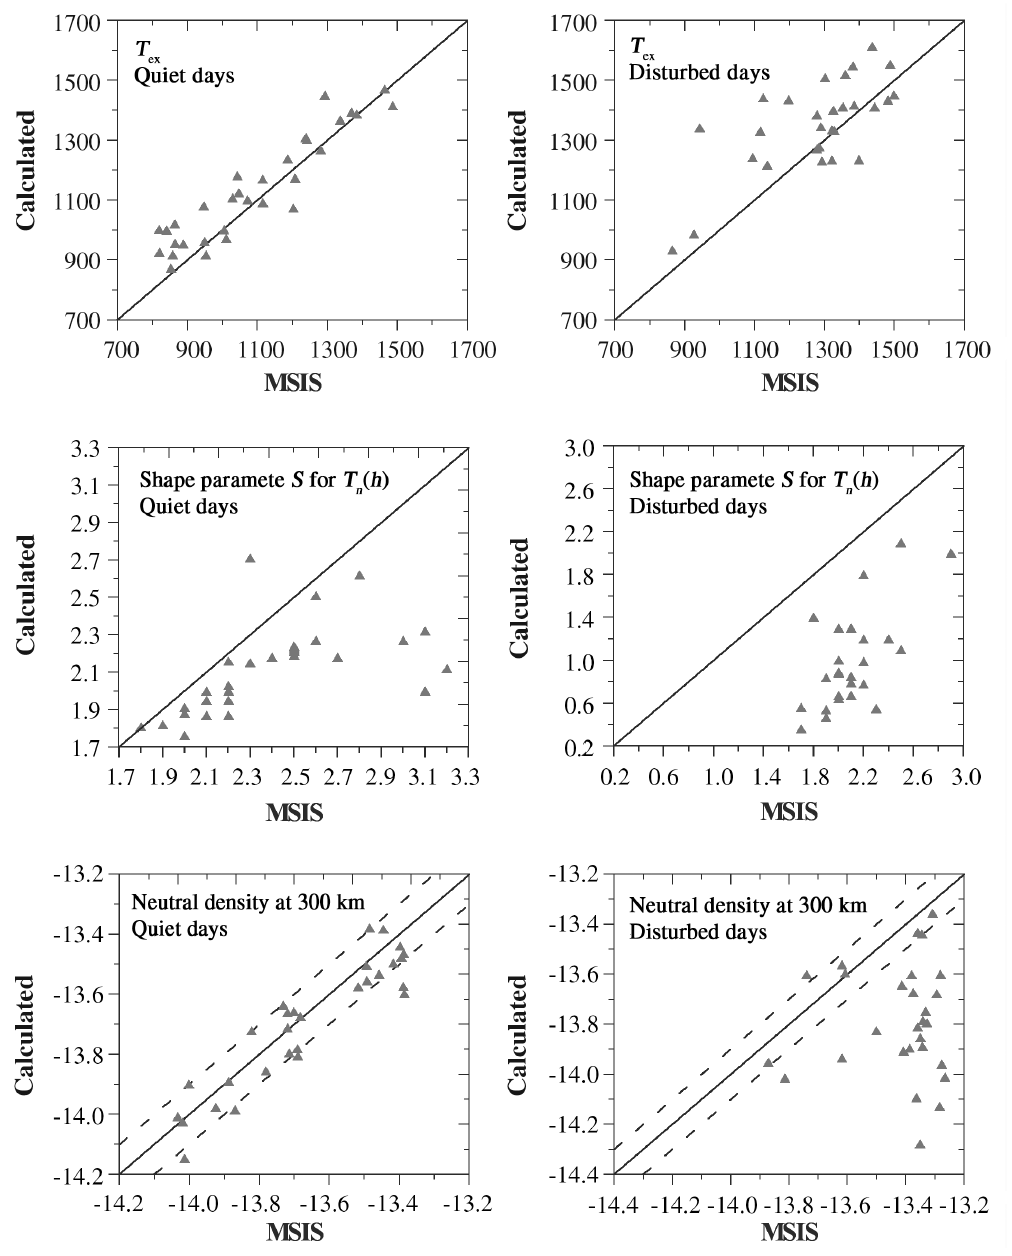
Fig. 4.5. A comparison of calculated versus MSIS-86 exospheric temperature T ex , shape parameter S , and total neutral density ρ at 300 km for quiet (left-hand panels) and disturbed (right-hand panels) days. T ex is in K , S is in 10 -2 km -1 units, and log ρ is in gcm -3 . Dashed lines indicate a ± 25% band around the